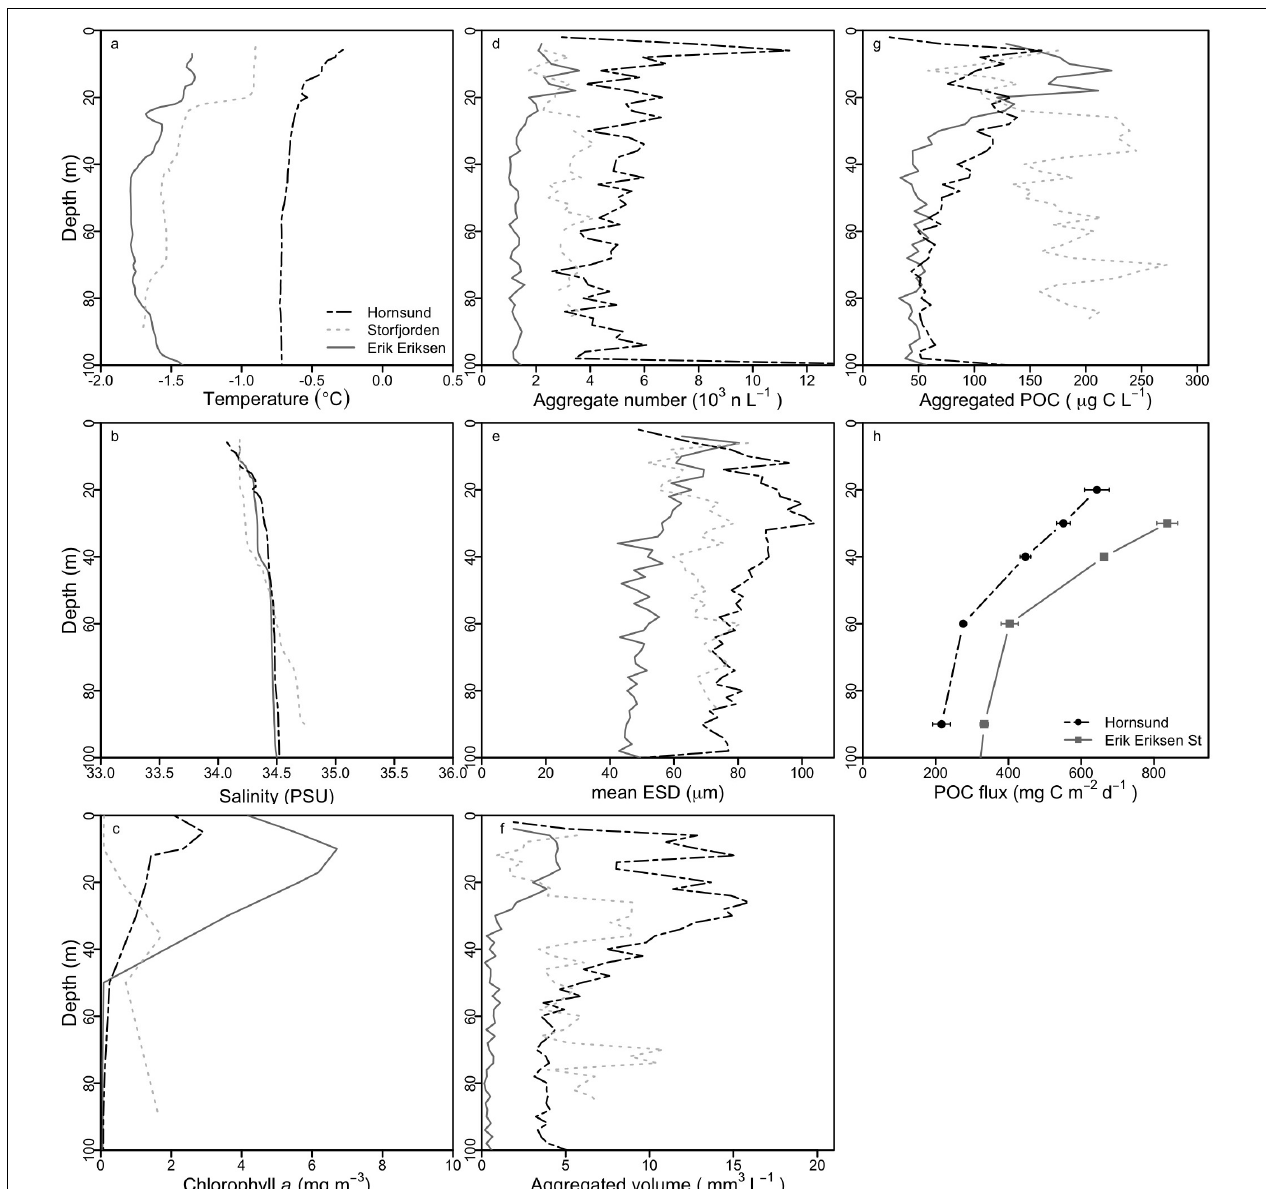
FIGURE 3 | Averaged depth profiles for investigated properties for measurements from stations in Erik Eriksen Strait (averaged values for five measurements), in Hornsund (averaged values for six measurements) and in Storfjorden (only one measurement), and POC fluxes from the sediment traps. (a) Temperature, (b) salinity, (c) chlorophyll a , (d) number of aggregates, (e) mean equivalent spherical diameter (ESD), (f) total aggregate volume, (g) total aggregated particulate organic carbon (POC), and (h) POC fluxes from sediment traps (average ±